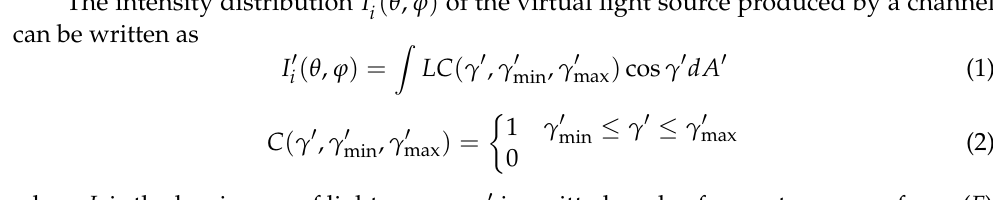
Figure 3. Principle of the elliptical reflector.